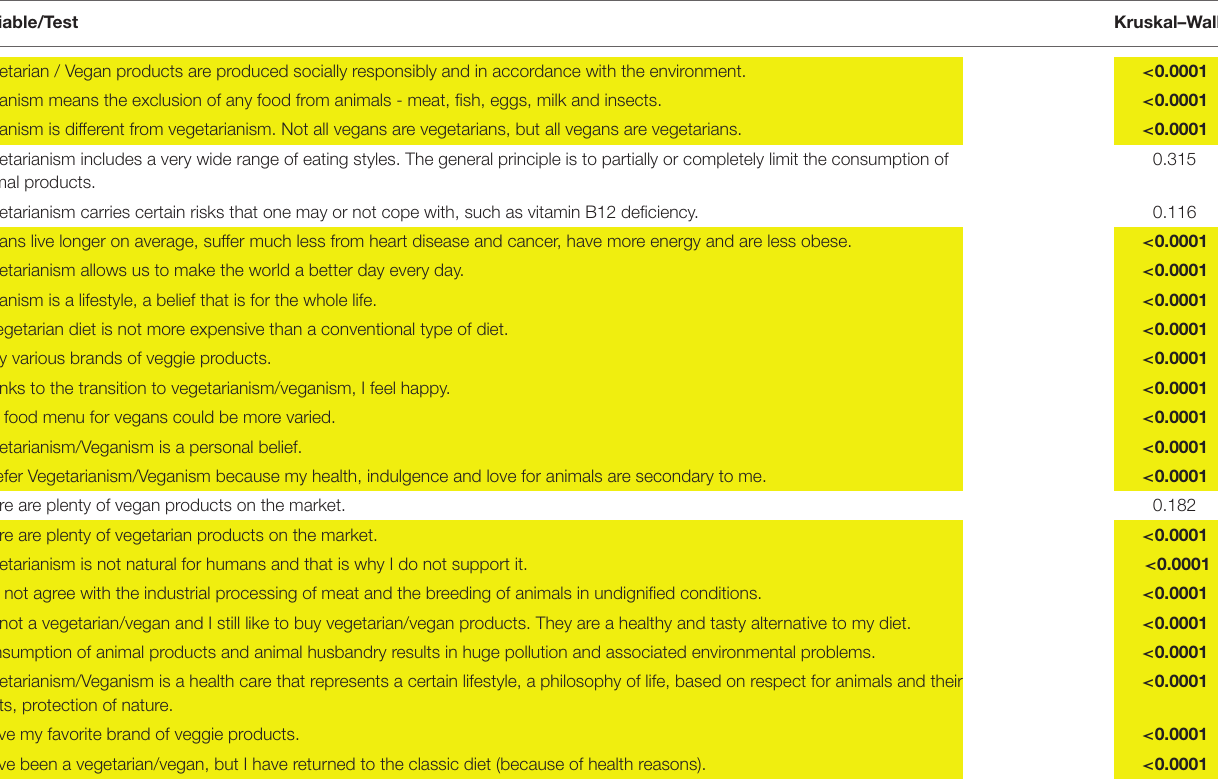
TABLE 3 | Results of the Kruskal–Wallis Test (dependence between agreement with the statement and the form of the respondent’s diet).